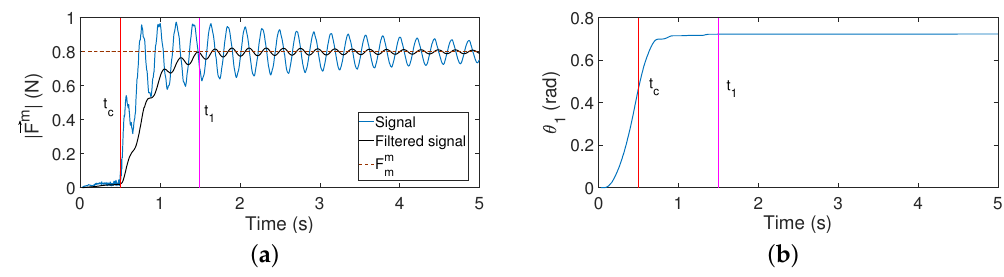
Figure 12. ( a ) Magnitude of the contact force | (cid:126) F m ( t ) | and its filtered signal; ( b ) motor angle.